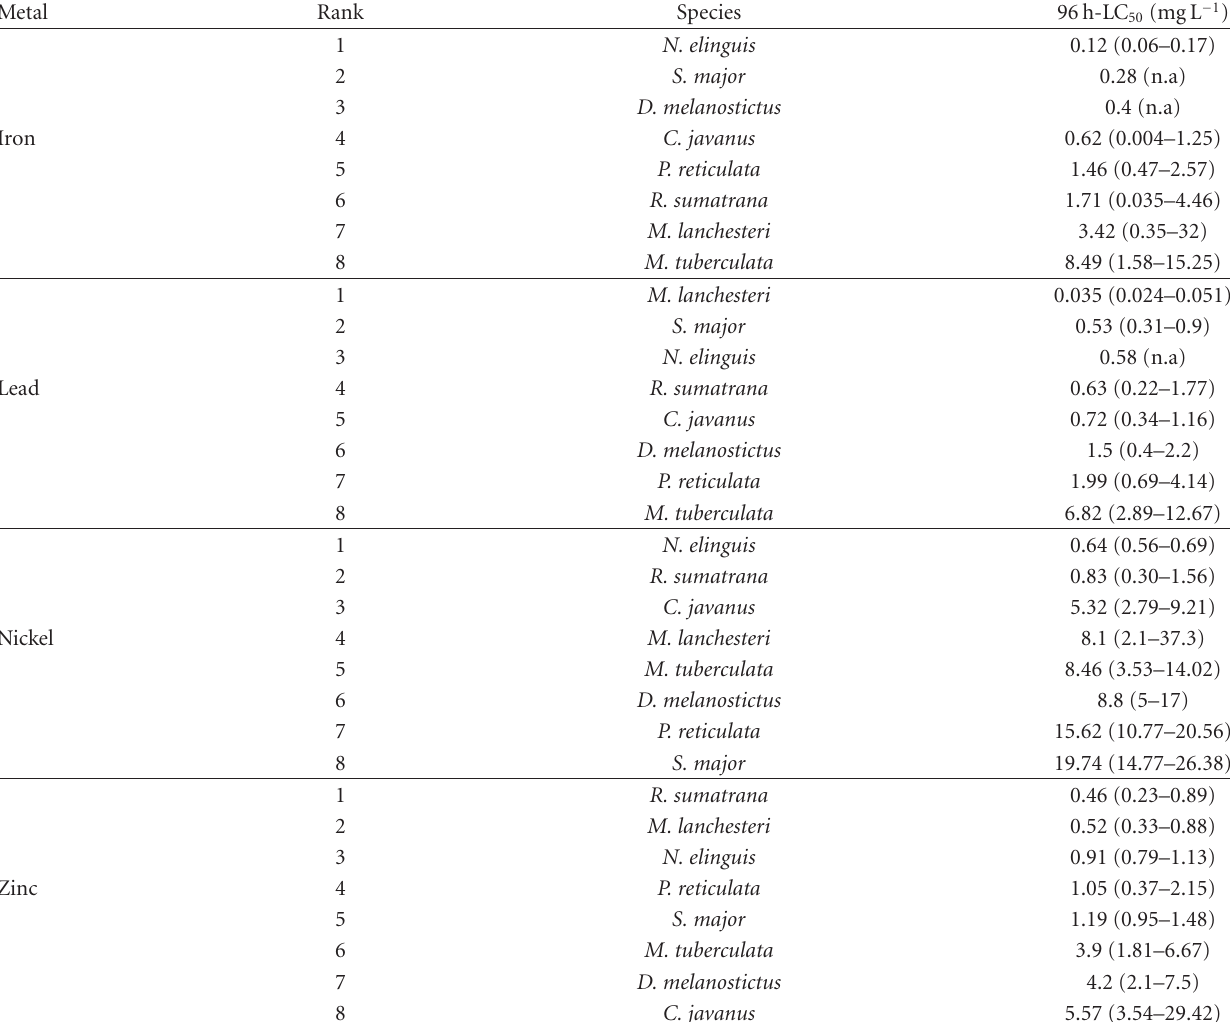
Table 1: Acute toxicity of Fe, Pb, Ni, and Zn to eight freshwater species (mean with 95% confidence limits).